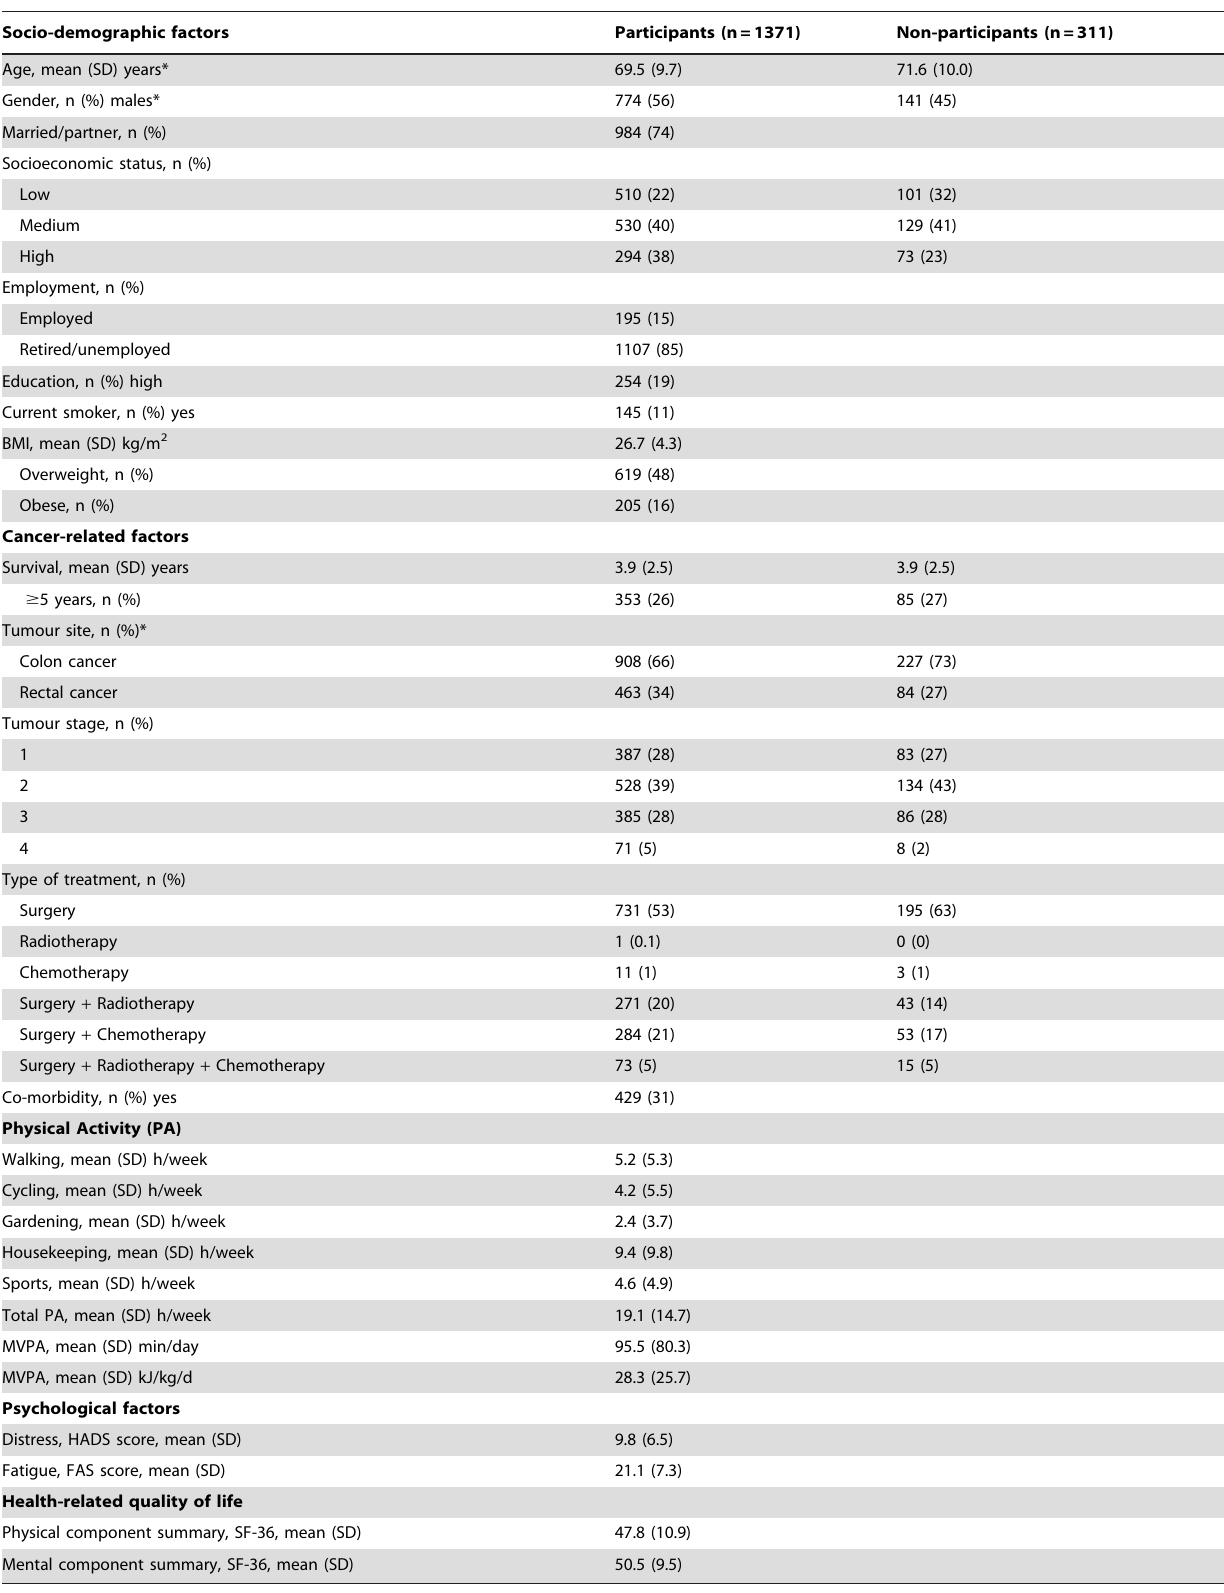
Table 1. Descriptive statistics of the study sample.